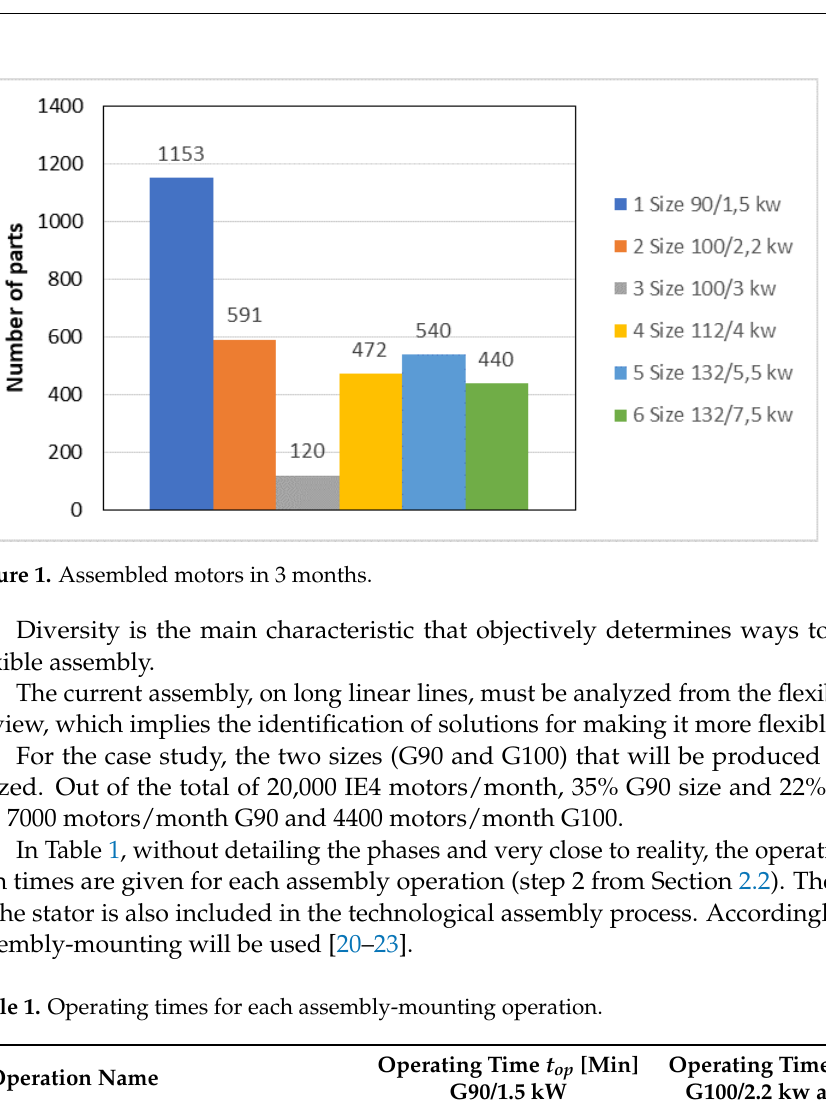
Table 1. Operating times for each assembly-mounting operation.